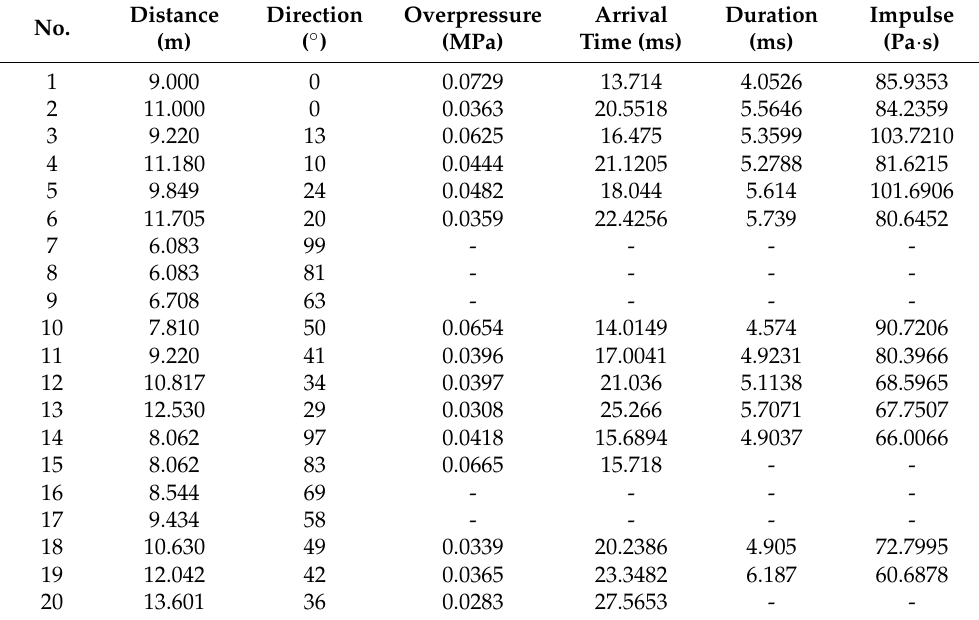
Table A2. Shock wave parameters of a moving charge explosion experiment ( V = 703 m/s, x = − 3 m).